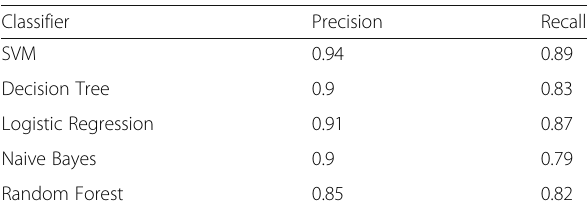
Table 4 Performance comparison under five-fold across